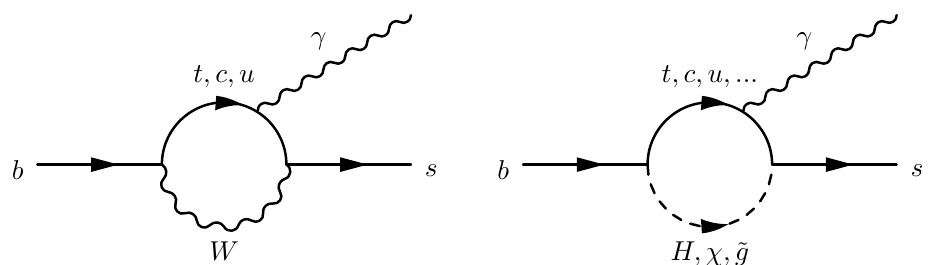
Figure 1 . The b → sγ penguin diagram, mediated by SM particles (left) and BSM particles (right).